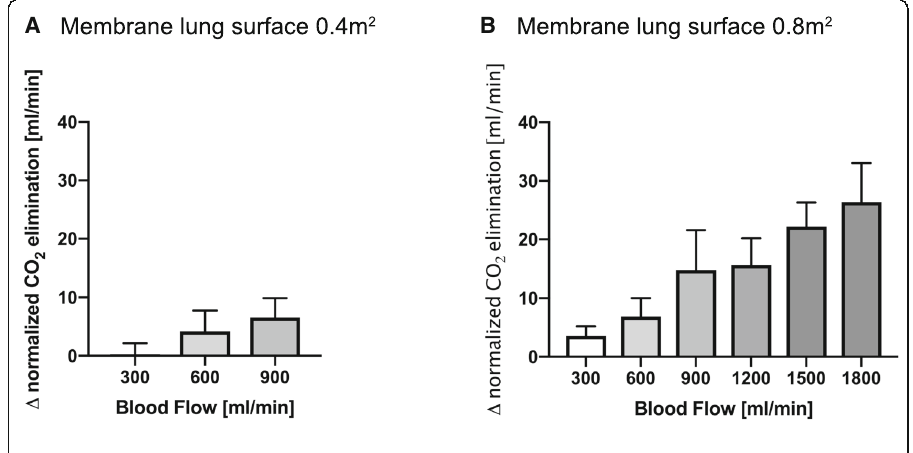
Fig. 2 Difference in normalized extracorporeal elimination of carbon dioxide (CO 2 ) between 8 and 2 L sweep gas flow/min depending on blood flow and membrane lung surface (0.4m 2 ( a ) and 0.8m 2 ( b ))